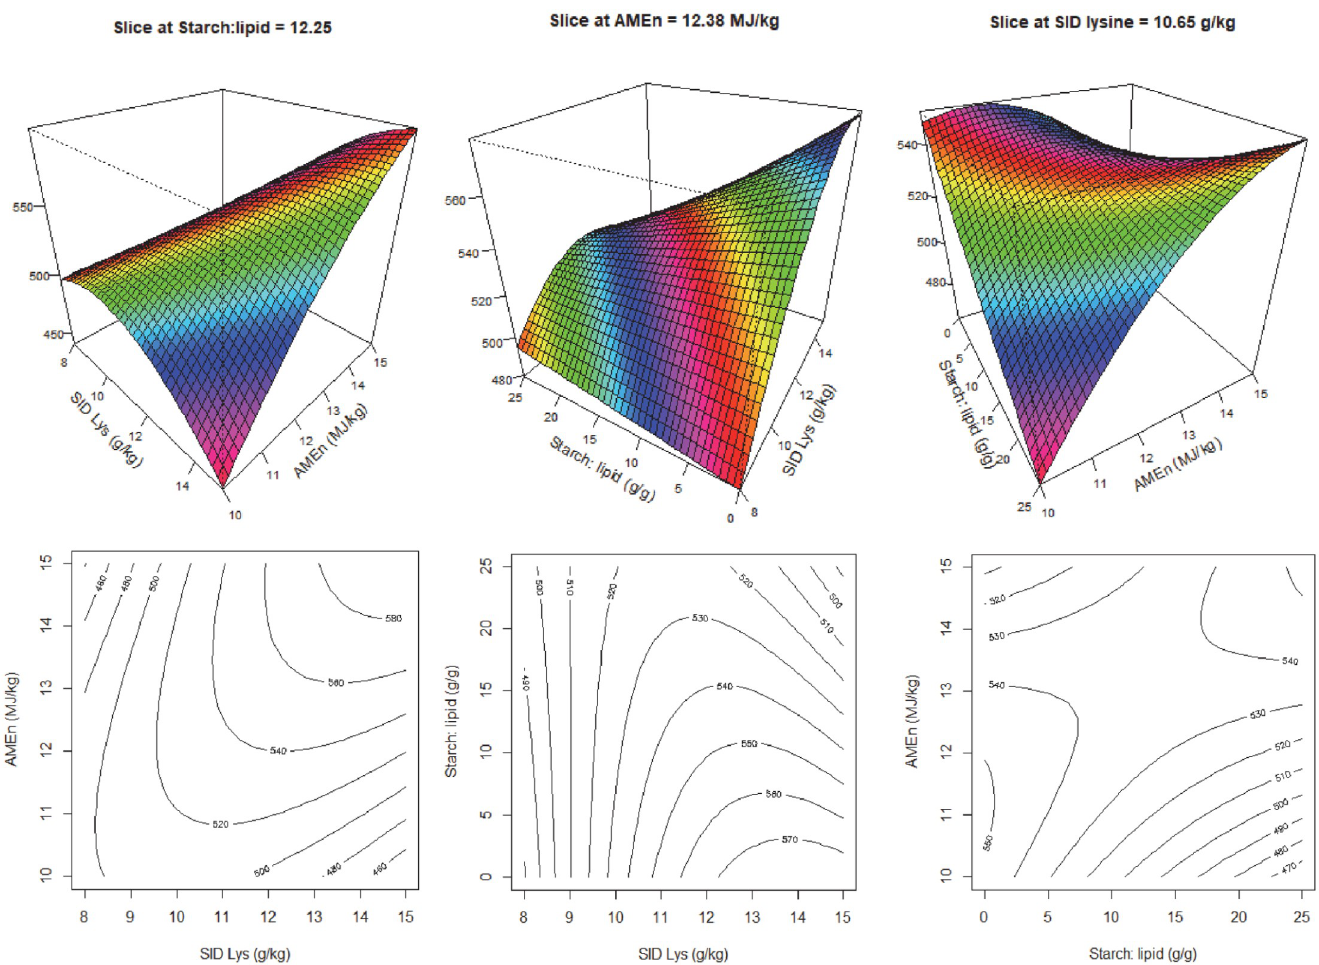
Fig 6. Response surface and contour plots describing relationships between leg quarters weight (g/bird) and digestible lysine concentration (SID Lys), energy density (AMEn) and starch to lipid ratios (S:L) in broiler chickens.